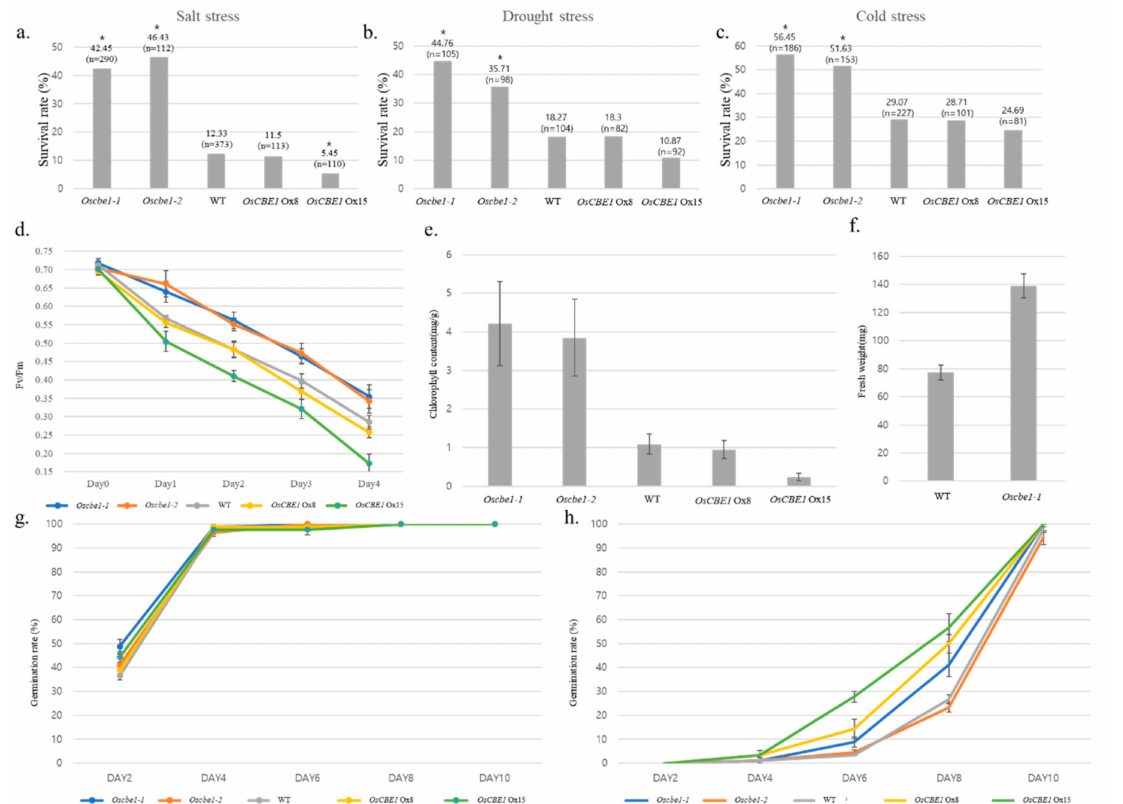
Figure 2. Phylogenetic traits of CBE1 lines. Abiotic stress tolerance was analyzed with survival rate in OsCBE1 lines. Before stress treatment, each plant was grown in soil for seven days. ( a ) Salt stress was treated for 84 h by irrigating with 250 mM NaCl solution. Survival rate was analyzed, after 7 days of recovery. ( b ) Drought stress treatment for 36 h by withholding water. Survival rate was analyzed after seven days of recovery. ( c ) Cold stress treatment for 96 h under 4 ◦ C and 130 µ Mm − 2 s − 1 light intensity. Survival rate was analyzed after seven days of recovery. ( d ) Decrease of chlorophyll florescence (Fv/Fm) of OsCBE1 lines during cold stress in 4 ◦ C and 130 µ Mm − 2 s − 1 light intensity was analyzed. ( e ) Chlorophyll contents of OsCBE1 lines after cold stress in 4 ◦ C and 130 µ Mm − 2 s − 1 light intensity for four days were analyzed. ( f ) Fresh weights of OsCBE1 lines after salt stress in 250 mM NaCl treatment for 84 h were analyzed. ( g ) Germination rate of transgenic lines of OsCBE1 were analyzed in a 1 MS, 27 ◦ C, dark condition after 50% bleach treatment 2 for 40 min. ( h ) Germination rate of transgenic lines of OsCBE1 were analyzed in 1 MS, 5 µ M ABA, 27 ◦ C, dark condition 2 after 50% bleach treatment for 40 min. *, significant difference from wild type (Chi-square test with p < 0.05); Error bar, ± Standard